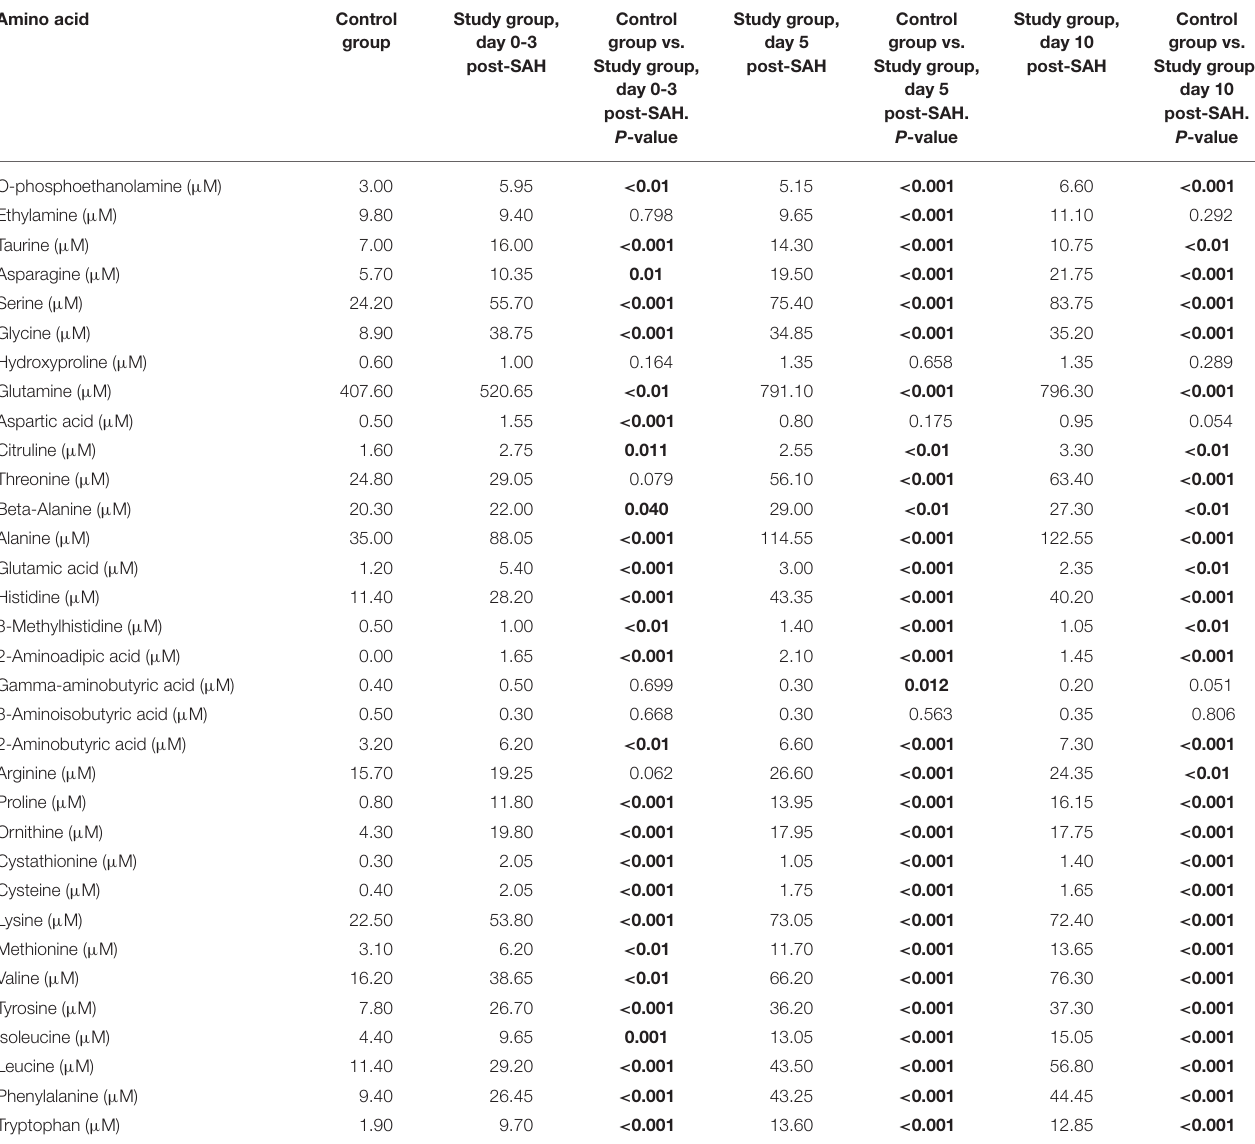
TABLE 2 | Differences in CSF amino acid level at day 0-3, 5, and 10 post-SAH in healthy individuals (control group) and SAH patients (study group). Amino acid Control